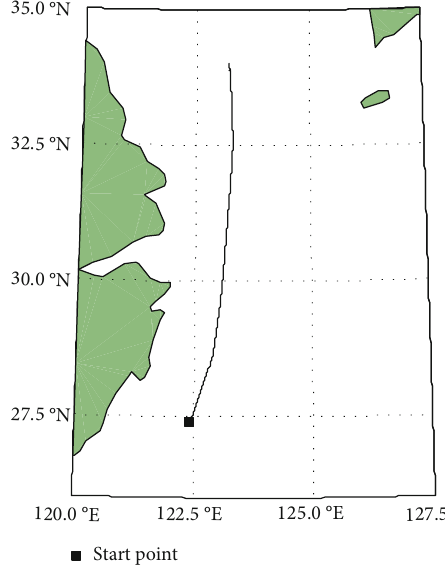
Figure 12: Ship ’ s 24-hour trajectory setting.